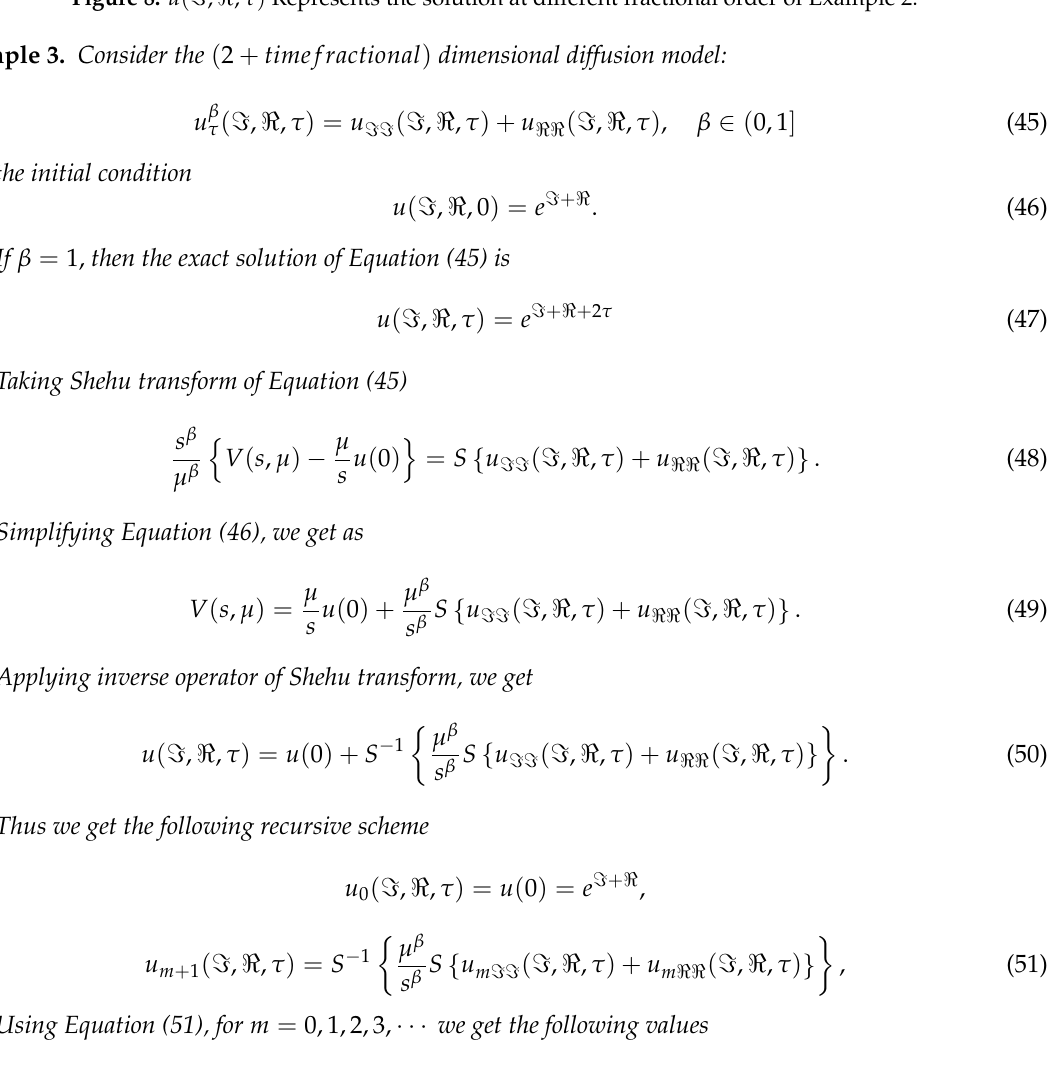
Figure 8. u ( (cid:61) , (cid:60) , τ ) Represents the solution at different fractional order of Example